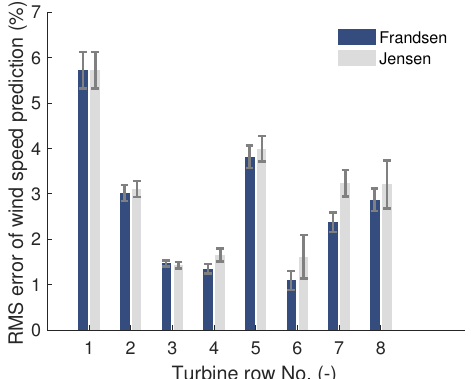
Figure 11. Effect of wake deficit model on error of DFP in estimation of current rotor effective wind speed at turbines of large-scale wind farm. Shown are the row-wise statistics, that is, mean (bars) and standard deviation (errorbars) of the normalized RMS difference of wind speed between the DFP and